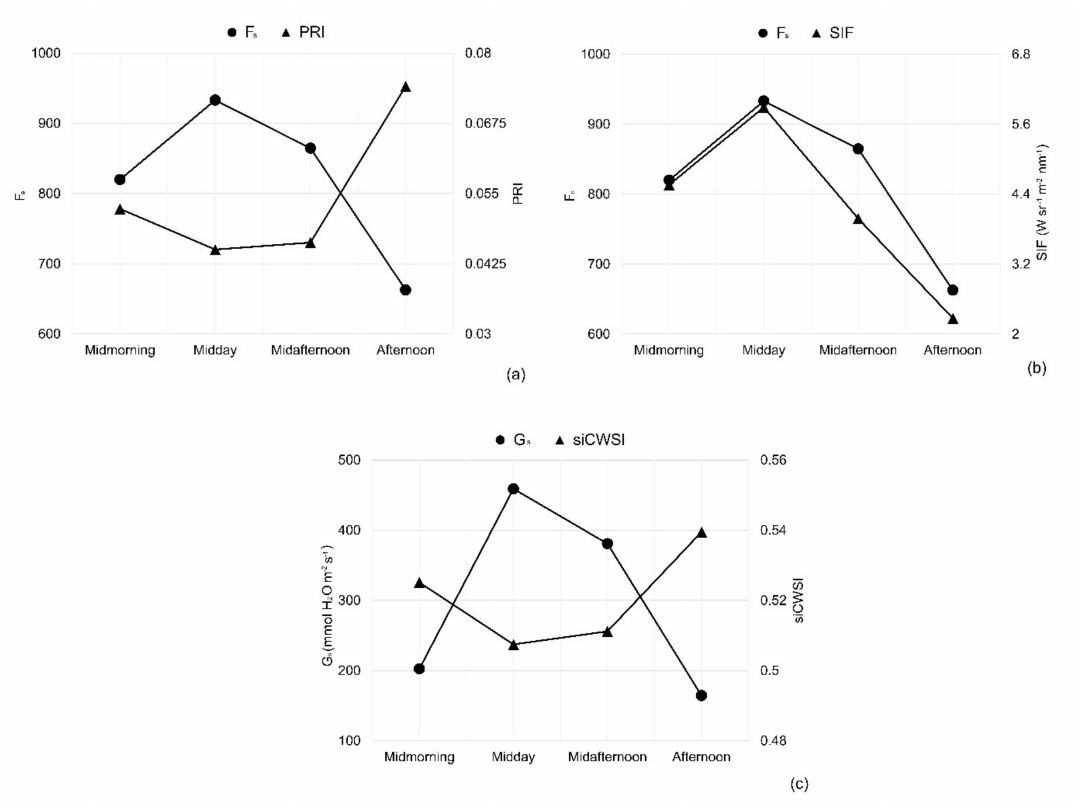
Figure 16. Diurnal trends for both in-situ physiological measurements and aerial image retrievals observed on 1 August 2018. ( a ) Steady-state fluorescence (F s ) and PRI, ( b ) F s and SIF, and ( c ) stomatal conductance (G s ) and